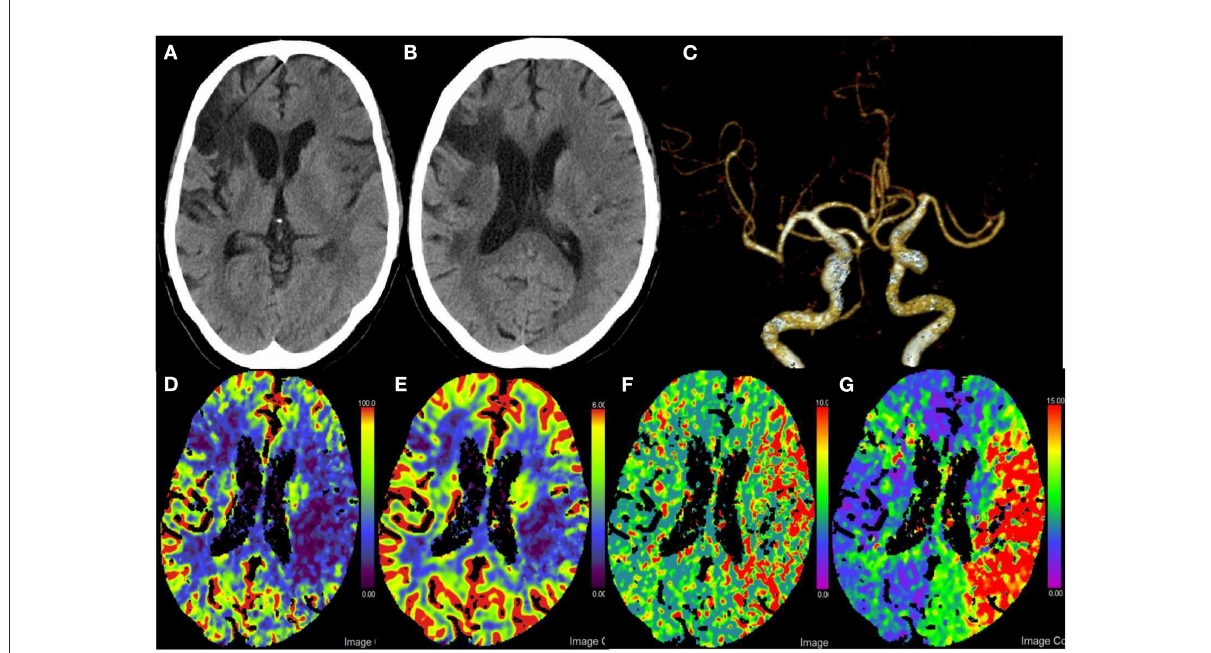
FIGURE1 Pre-procedural imaging. (A,B) Axial pre-procedural CT of the head non-contrast shows the blurring of the gray-white border in the middle third and fourth of the left middle cerebral artery (MCA) territory. (C) Pre-procedural CT angiography demonstrating occlusion of the M1 terminus. (D–G) Pre-procedural CT perfusion shows decreased CBF and CBV and increased MTT and TTP in the left MCA territory. CBF suggests a large area of hypoperfusion in the left cerebral hemisphere; CBV suggests an infarct core that is smaller in extent than CBF, suggesting a mismatch in CBF/CBV, which may be good candidates for reperfusion